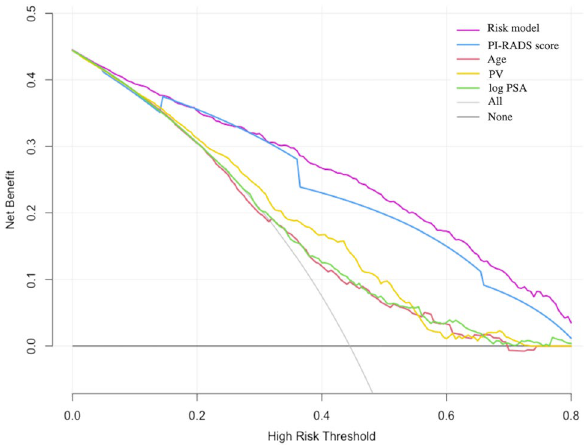
Figure 4. Net DCA demonstrating the benefit for predicting sPC on